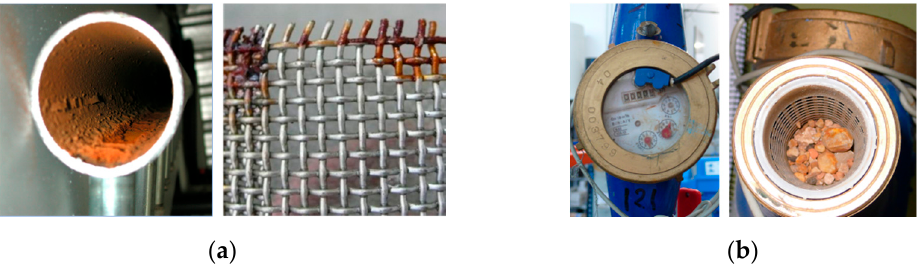
Figure 10. Problems of multioutlet hydrants in the field: ( a ) metal oxidation of the mesh filter and hydrant entrance; ( b ) lack of maintenance in water meters (e.g., sand in the inlet filter).